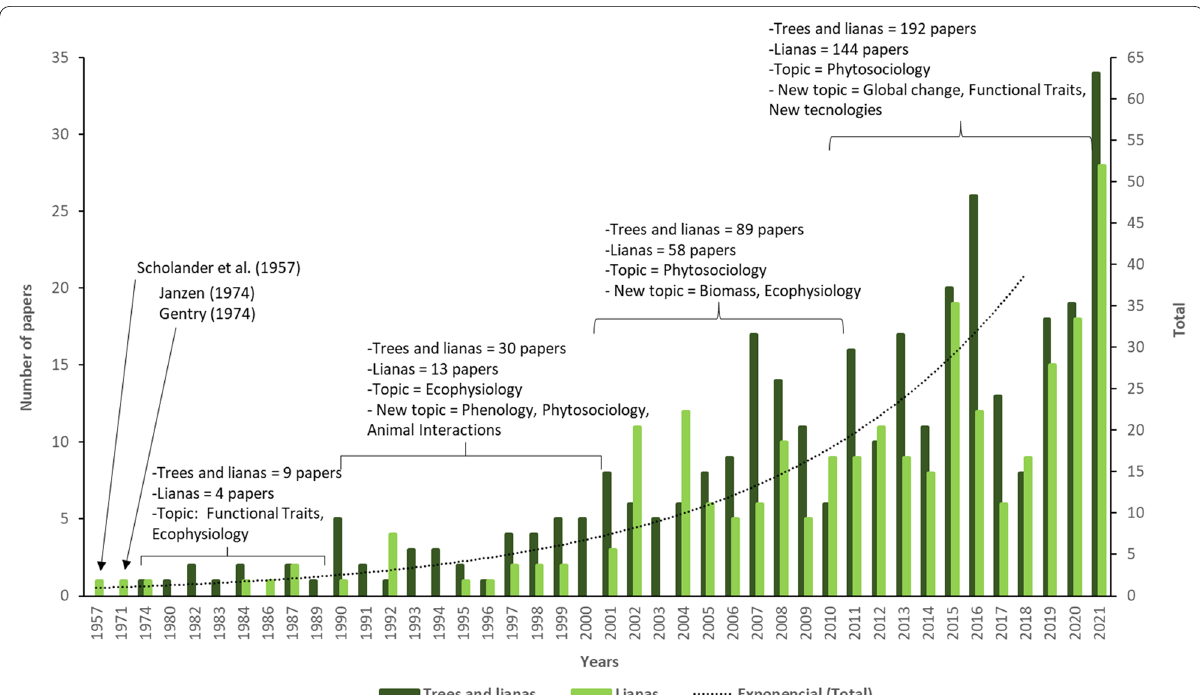
Fig. 1 Literature produced on neotropical region by country from 1957 to 2021. Light green bars indicate research papers focused just on lianas and dark green bars papers comparing lianas and